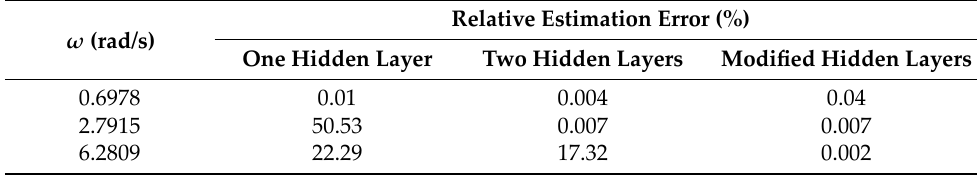
Table 3. Estimation of PINN for the first three modal dynamic characteristics.